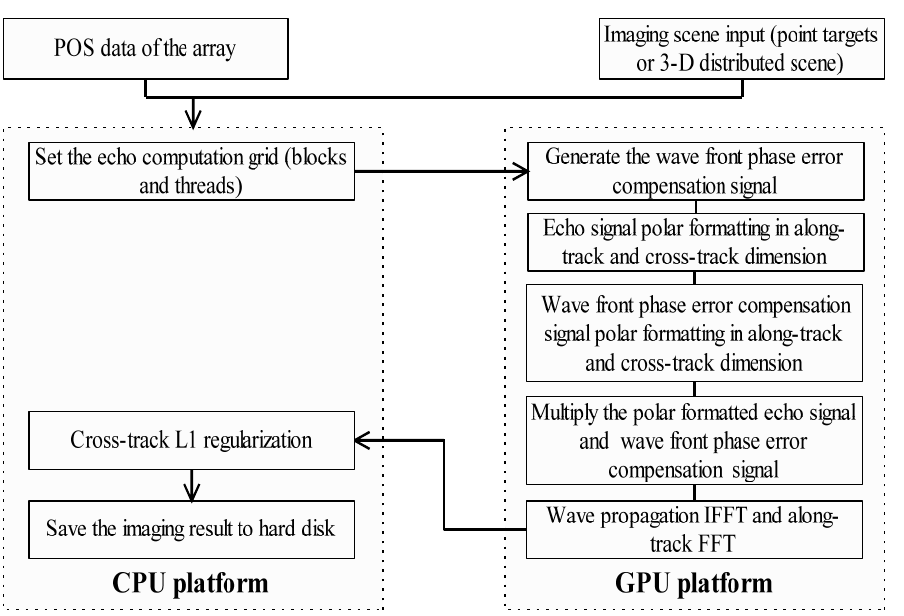
Figure 7. Heterogeneous parallel image reconstruction simulation with polar formatting and L1 regularization